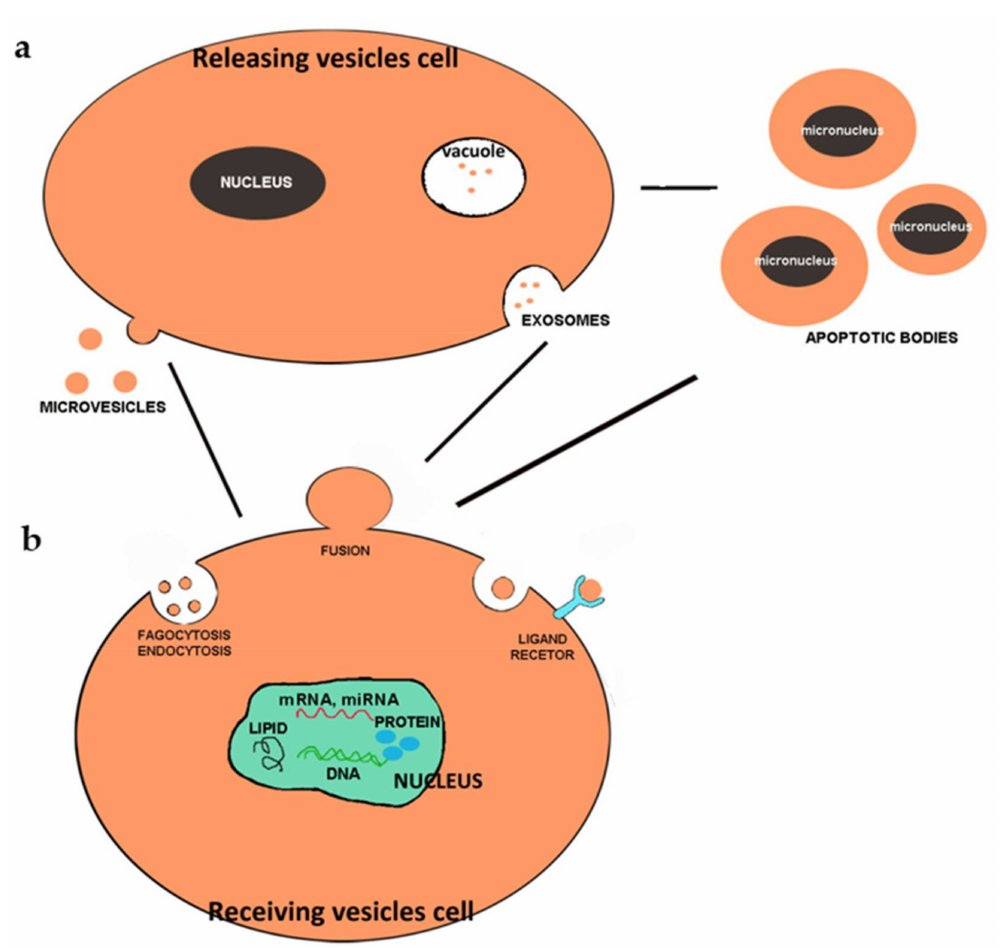
Figure 1. Scheme showing the various types of extracellular vesicle released by the cells ( a ) and the possible mechanisms of interaction with other cells ( b